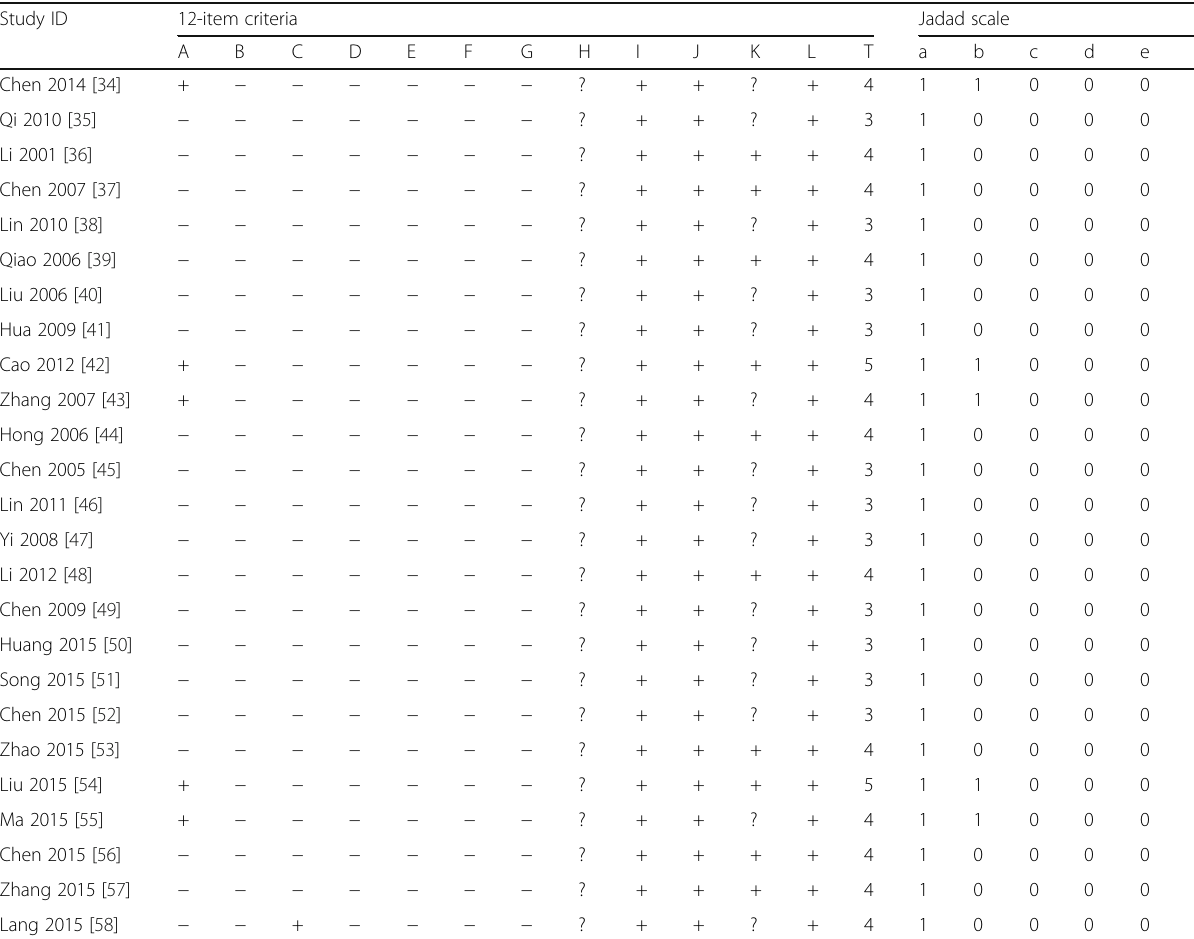
Table 2 Quality of the included trials Study ID 12-item